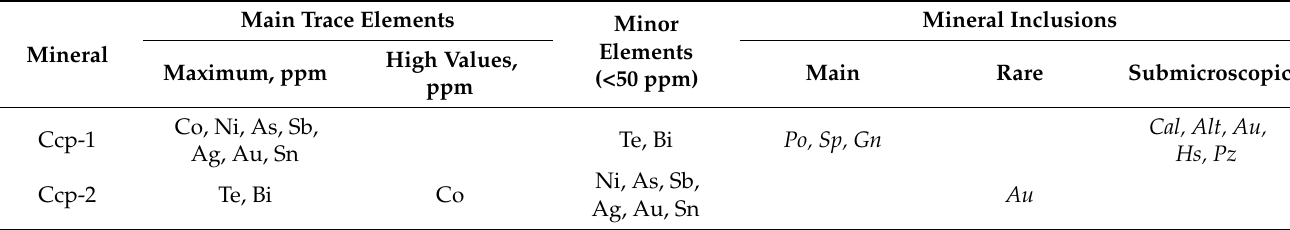
geom. mean Table 17. Occurrence forms of main and trace elements and their mineral inclusions in chalcopyrite of different assemblages at the Novogodnee-Monto deposit.